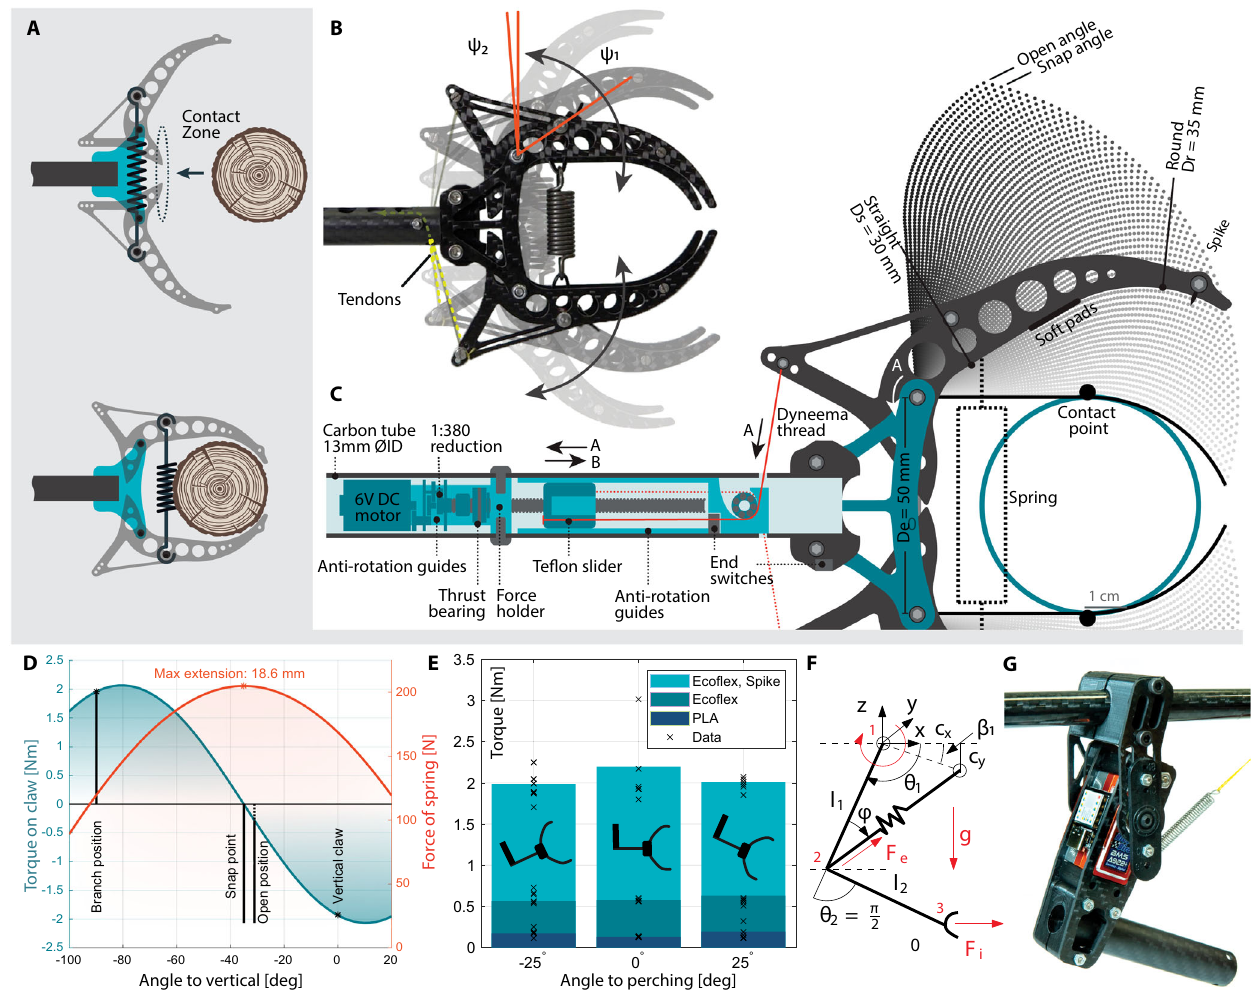
Fig. 2 | Design of the leg-claw appendage. A Bistable claw con fi guration, before andaftercontact. B Photocompositionoftheclawinopen,closed,andin-between positions. Open angle is Ψ 1 and closed angle is Ψ 2 . The visible spring absorbs the impact. C Tendon-pullingre-openingmechanismentirelyintegratedwithintheleg tube,seearenderedsectionviewinSupplementaryFig.12andmodeledgeometry